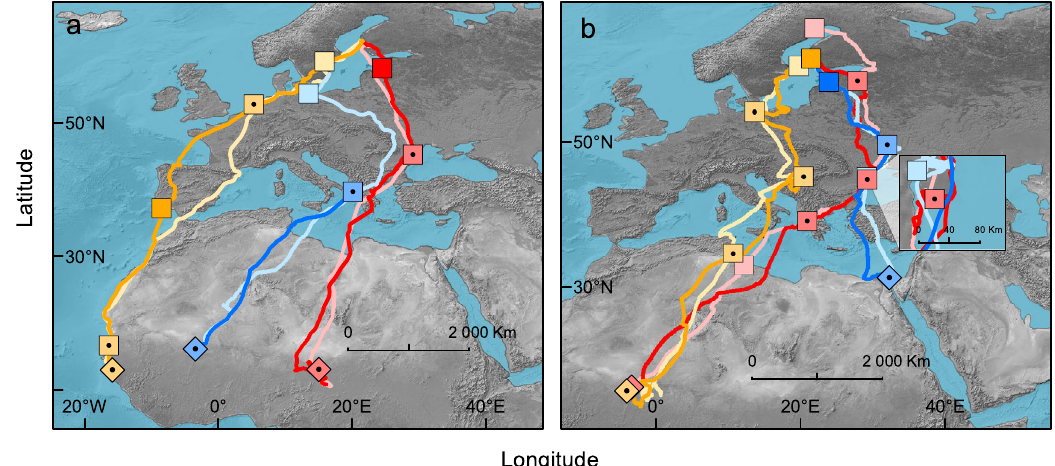
Fig. 3 Repeated use of autumn migration routes and stopover sites of young/subadult and adult Caspian terns in two consecutive years during 2017 – 2020. Migration routes ( n = 12) are depicted with lines, mean locations of stopover sites ( n = 32) with squares, mean locations of wintering sites ( n = 6) with diamonds. For both routes and stopover sites, a dark colour shade refers to the most recent year, whereas a light shade refers to a more distant year. Squares/diamonds with a black central dot and of an intermediate shade indicate stopover sites/wintering sites that were used in multiple years (twice), simple squares sites that were used in only one year. a Repeat migration routes and stopover site use of one young/subadult (blue) and two adults (red, yellow). The information from the young is from 2018 (year of birth) and 2020 ( fi rst year of [partial] autumn migration – bird returned only halfway to Eastern Europe), that of the adults depicted in red and yellow (female parents from family groups 4 and 8, respectively; Supplementary Table 1) are from 2018 and 2019. b Repeat migration routes and stopover site use of two young/subadult (red, yellow) and one adult (blue). The information from the young depicted in red are from 2018 (year of birth) and 2020 ( fi rst year of autumn migration), that of the young depicted in yellow are from 2017 (year of birth) and 2020 ( fi rst year of autumn migration) and that of the adult in blue (foster male parent from family group 8, Supplementary Table 1) are from 2018 and